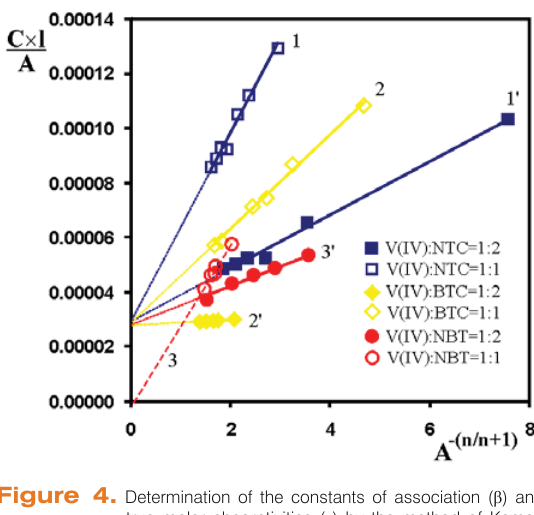
Figure 4. Determination of the constants of association ( β ) and true molar absorptivities ( ε ) by the method of Komar- Tolmatchev. C =2×10 -4 mol L -1 , pH=4.75 (lines 1,1’,2 PAR and 2’) or pH=4.1 (lines 3 and